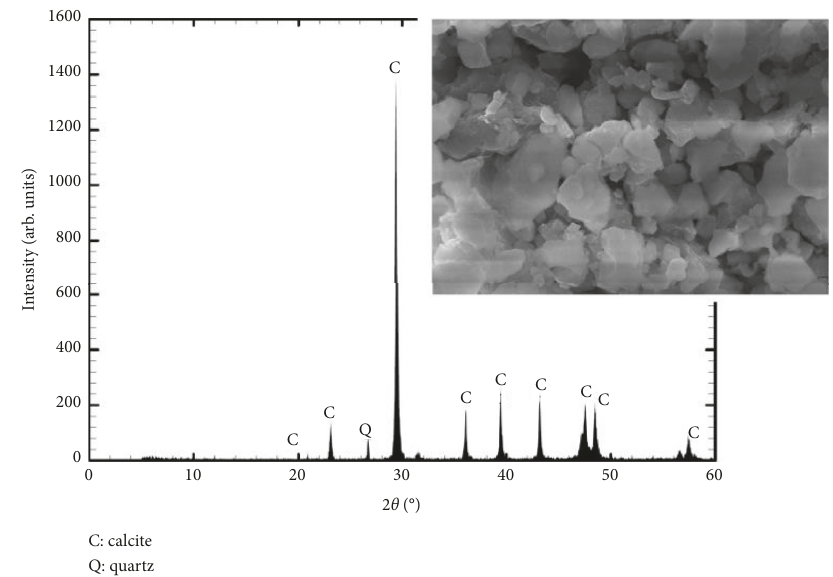
Figure 9: SEM micrographs and XRD patterns of limestone powder paste.